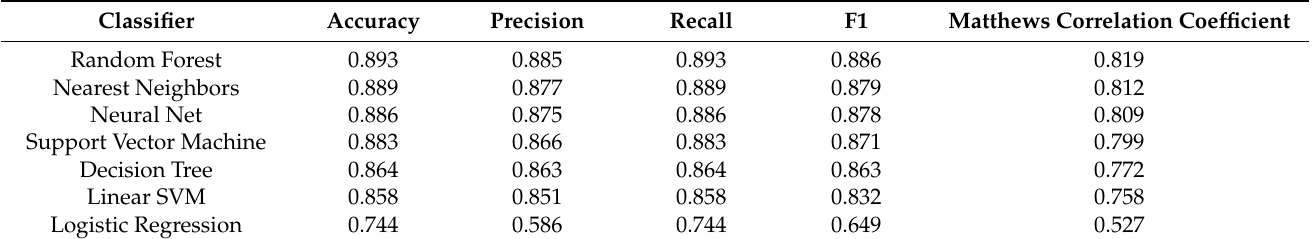
Table 6. Comparison of the accuracy metrics for supervised algorithms trained and evaluated on the dataset with all faults.